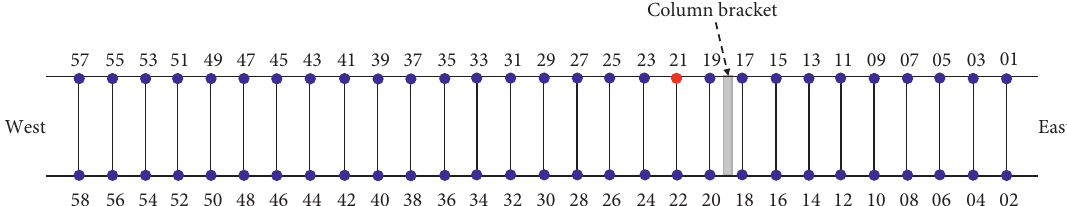
Figure 2: Schematic diagram of measurement grid. TP 21 in red is the reference point.